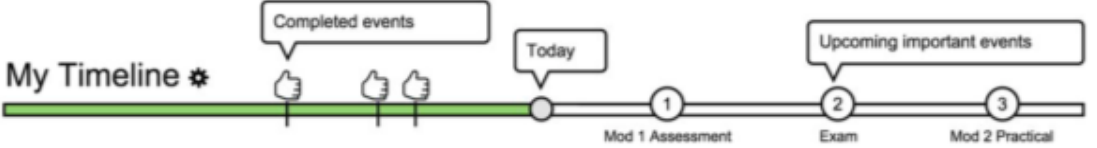
Figure 1 . Timeline representation combining progress and scheduling